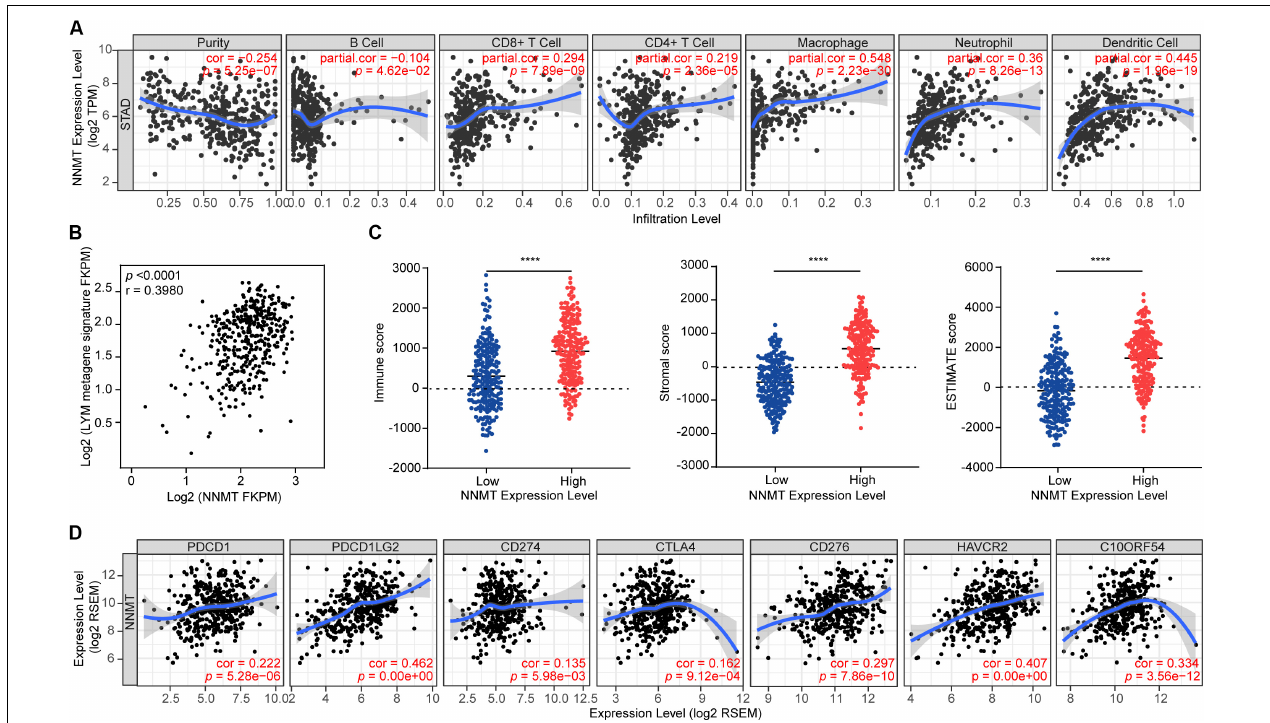
FIGURE 4 | Correlation of NNMT expression with immune infiltration level in STAD. (A) NNMT expression is negatively correlated with tumor purity and infiltrating level of B cells ( r = –0.104, p = 4.62e–02), and has significant positive correlations with infiltrating levels of CD8 + T cells ( r = 0.294, p = 7.89e–09), CD4 + T cells ( r = 0.219, p = 2.36e–05), macrophages ( r = 0.548, p = 2.23e–30), neutrophils ( r = 0.36, p = 8.26e–13), and dendritic cells ( r = 0.445, p = 1.96e–19) in STAD ( n = 415). (B) The average expression of the LYM metagene signature in each GC patient from TCGA is shown relative to that for NNMT mRNA. (C) NNMT mRNA levels are shown relative to levels of immune, stromal, and ESTIMATE gene signatures calculated by the ESTIMATE algorithm, **** p < 0.0001. (D) NNMT expression correlated with the checkpoint molecules in STAD. Markers include PDCD1 (PD1), PDCD1LG2 (PDL2), CD274 (PDL1), CTLA4, CD276 (B7-H3), HAVCR2 (TIM-3), and C10ORF54